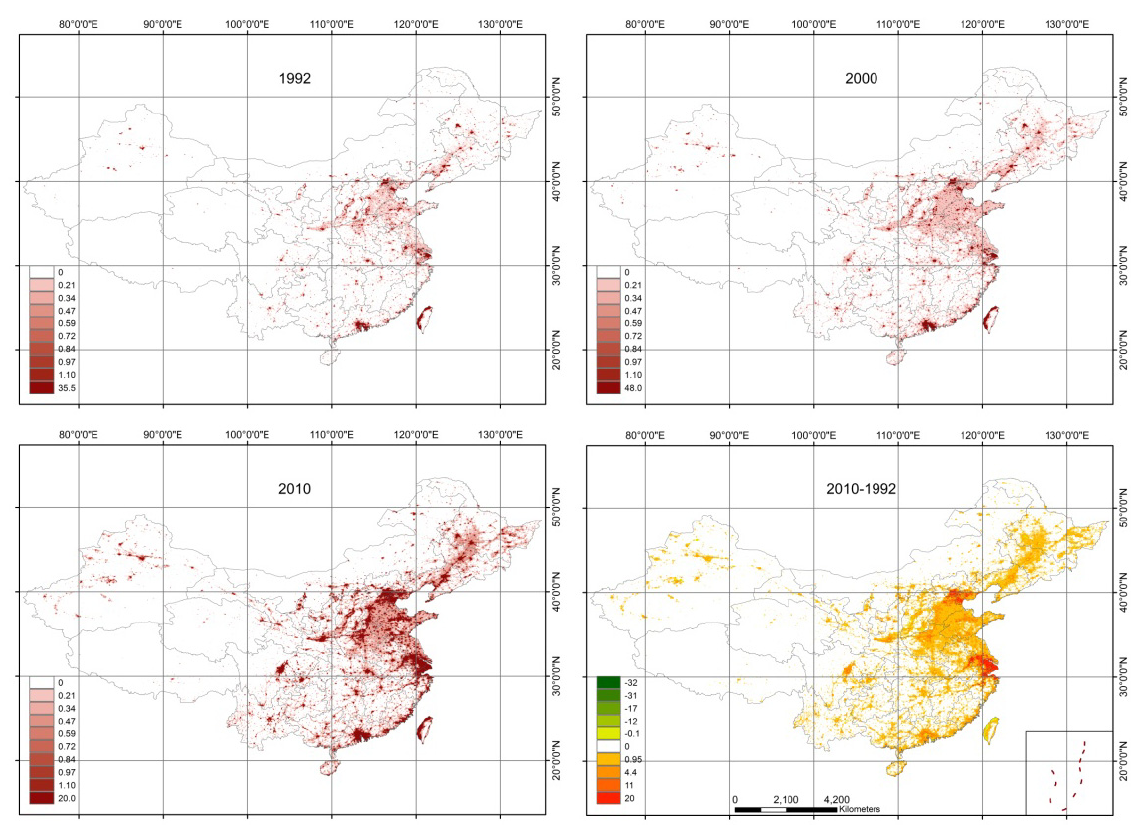
Figure 4. Spatial patterns of AHF and spatial differences of distributions from 1992 to 2010 (units: Wm − 2